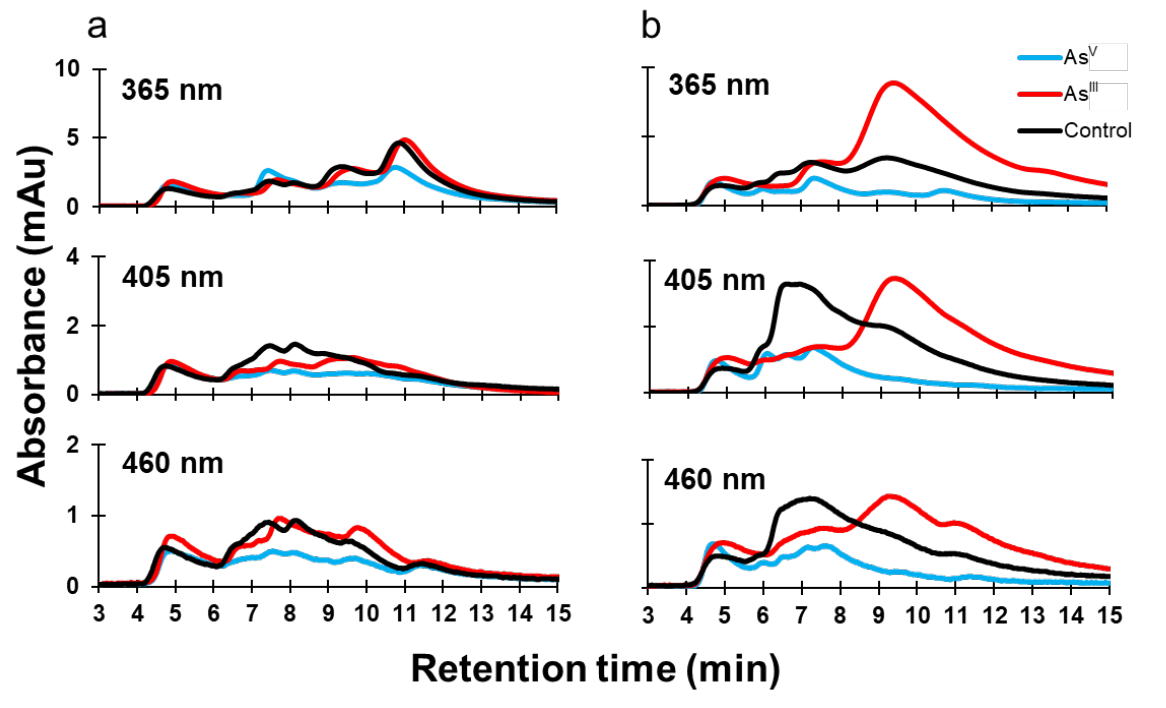
Figure 5. Protein-bound cofactor distribution changes caused by arsenic treatment. Soluble proteomes were analyzed on an SEC coupled with a DAD detector. The wavelengths 365, 405, and 460 nm were monitored for K-12 ( a ) and AW3110 ( b ) under three conditions: control (black), As V (cyan), and As III (red).